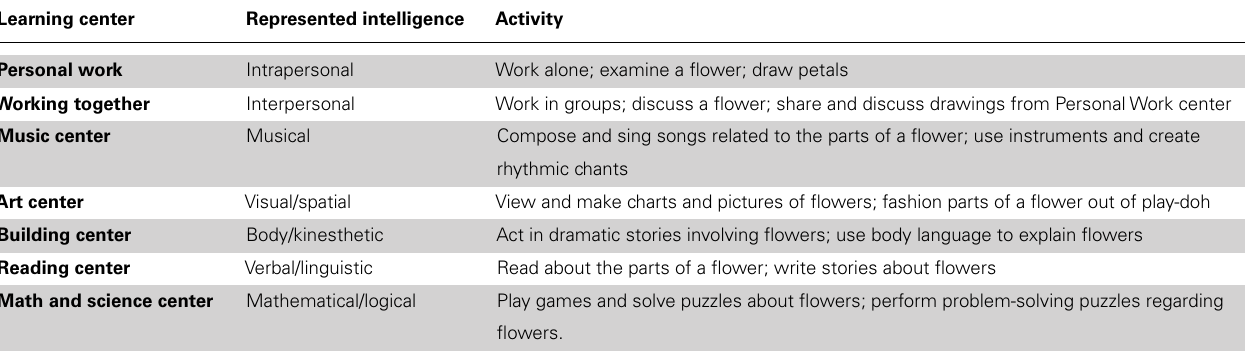
Table 1 | MI centers in diversity of living things experimental